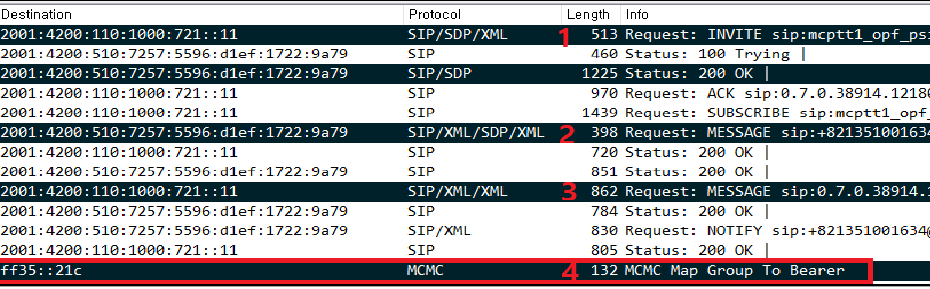
Figure 8. Logs of eMBMS.